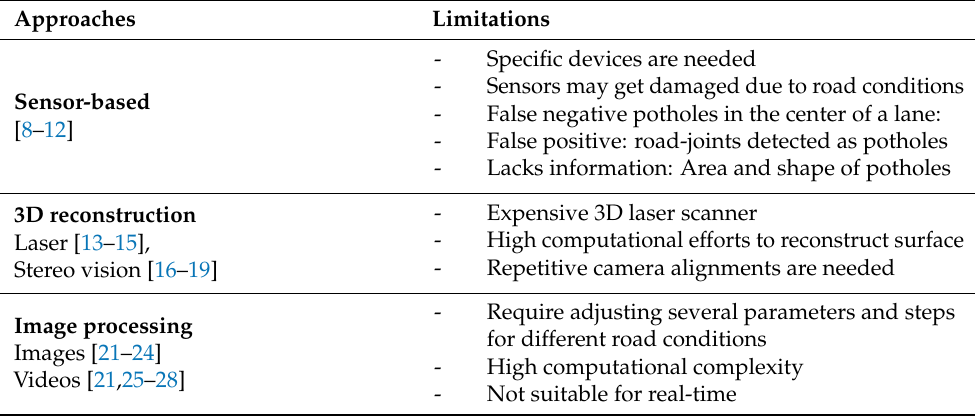
Table 1. Pothole detection